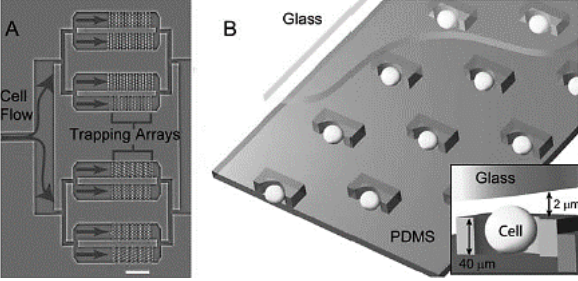
Figure 8. ( A ). Architecture of the system proposed by Di Carlo et al. The scale bar is 500 µm; ( B ). Diagram of the microfluidic chip and the trapping mechanism. “Reproduced from [65] with permission of The Royal Society of Chemistry”.